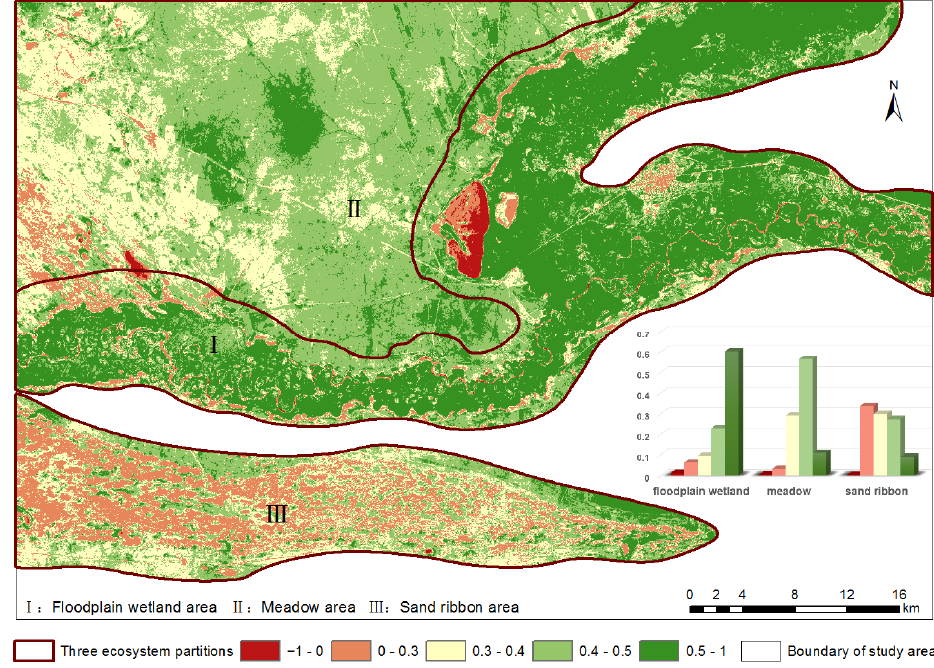
Figure 4. Spatial distribution of the NDVI maximum value composite and the area ratio histogram.